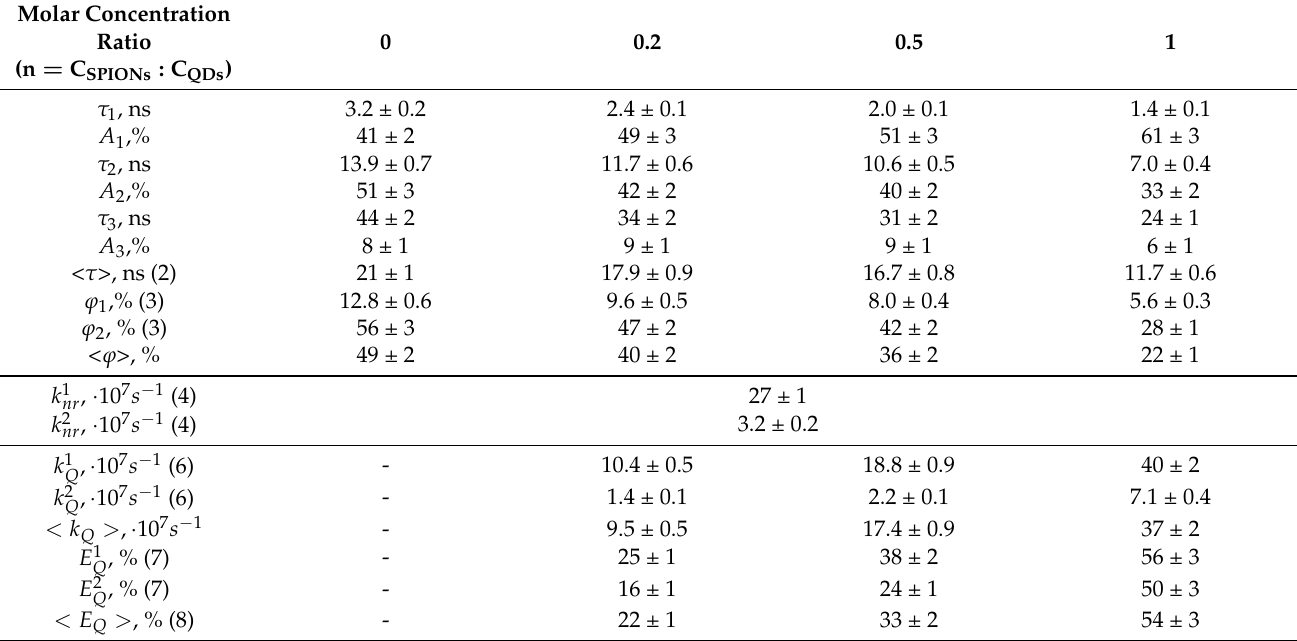
Table 1. Photophysical properties of QDs and QD-SPION nanocomposites